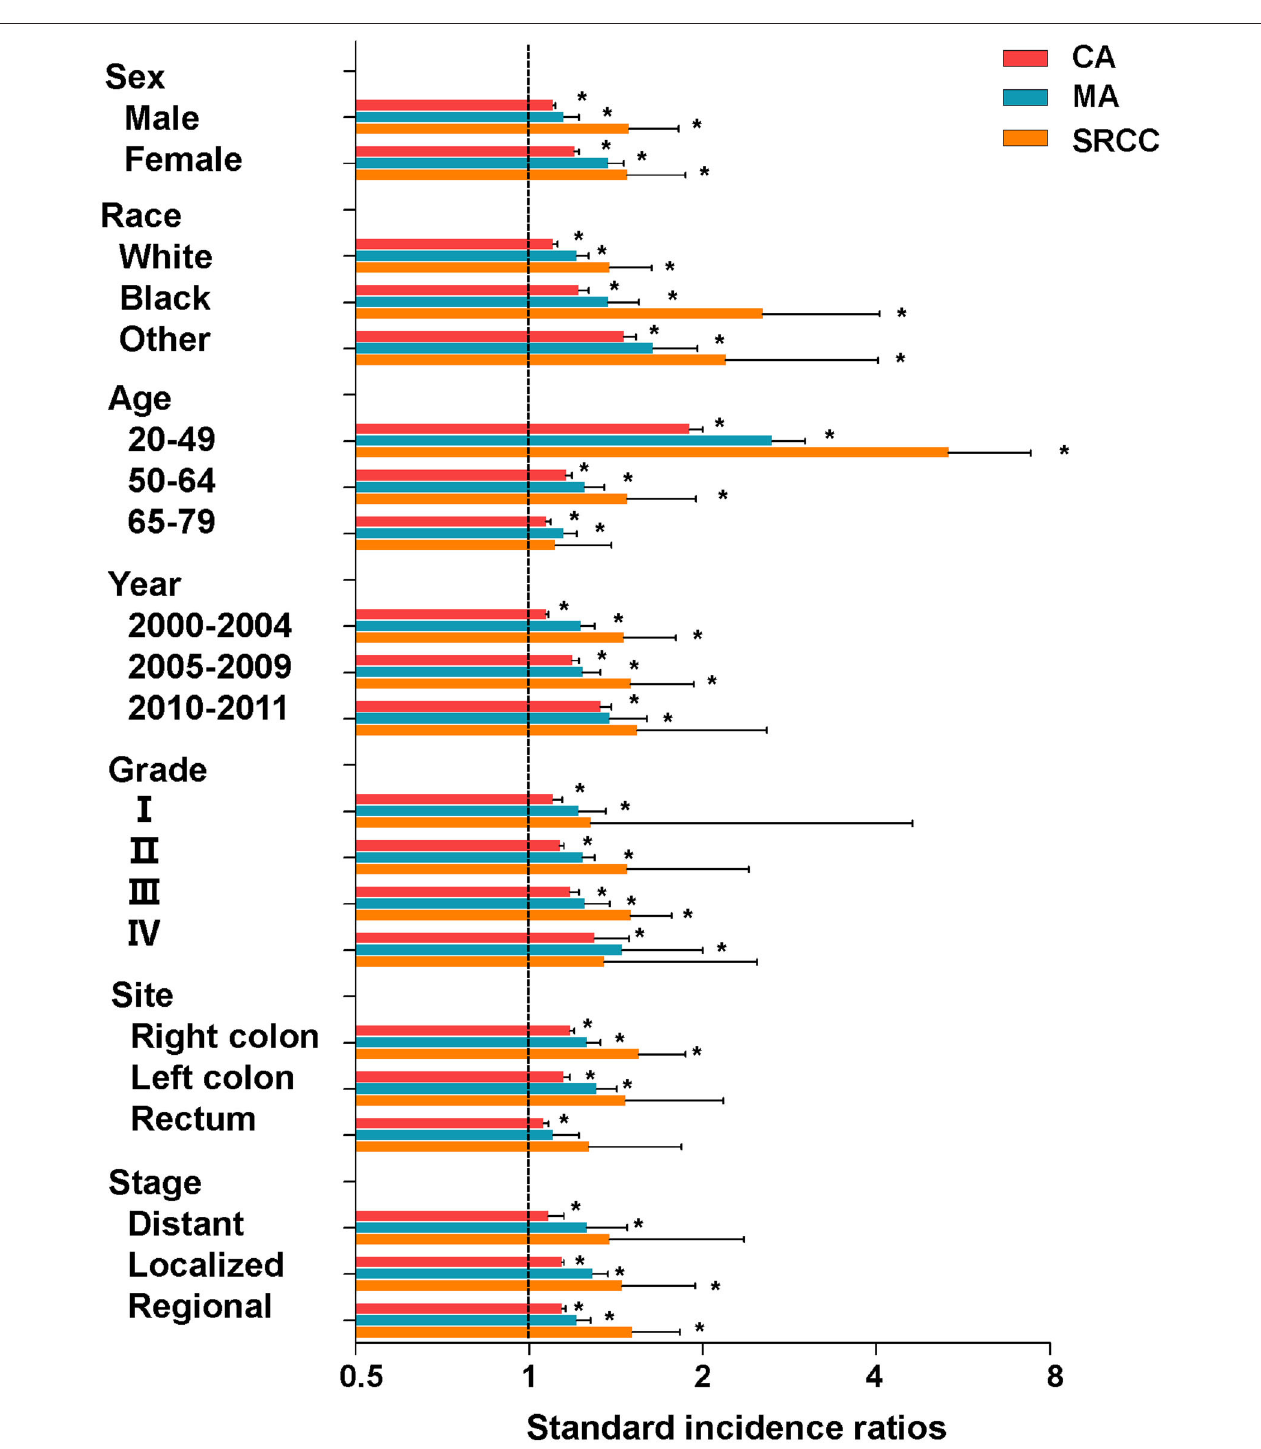
FIGURE 2 | SIRs for SPMs at all anatomical sites combined among CRC survivors stratified by sex, race, age, year, grade, site, stage, and histological subtype. CA, classical adenocarcinoma; MA, mucinous adenocarcinoma; SRCC, signet-ring cell carcinoma. * P < 0.05 (compared with general population).